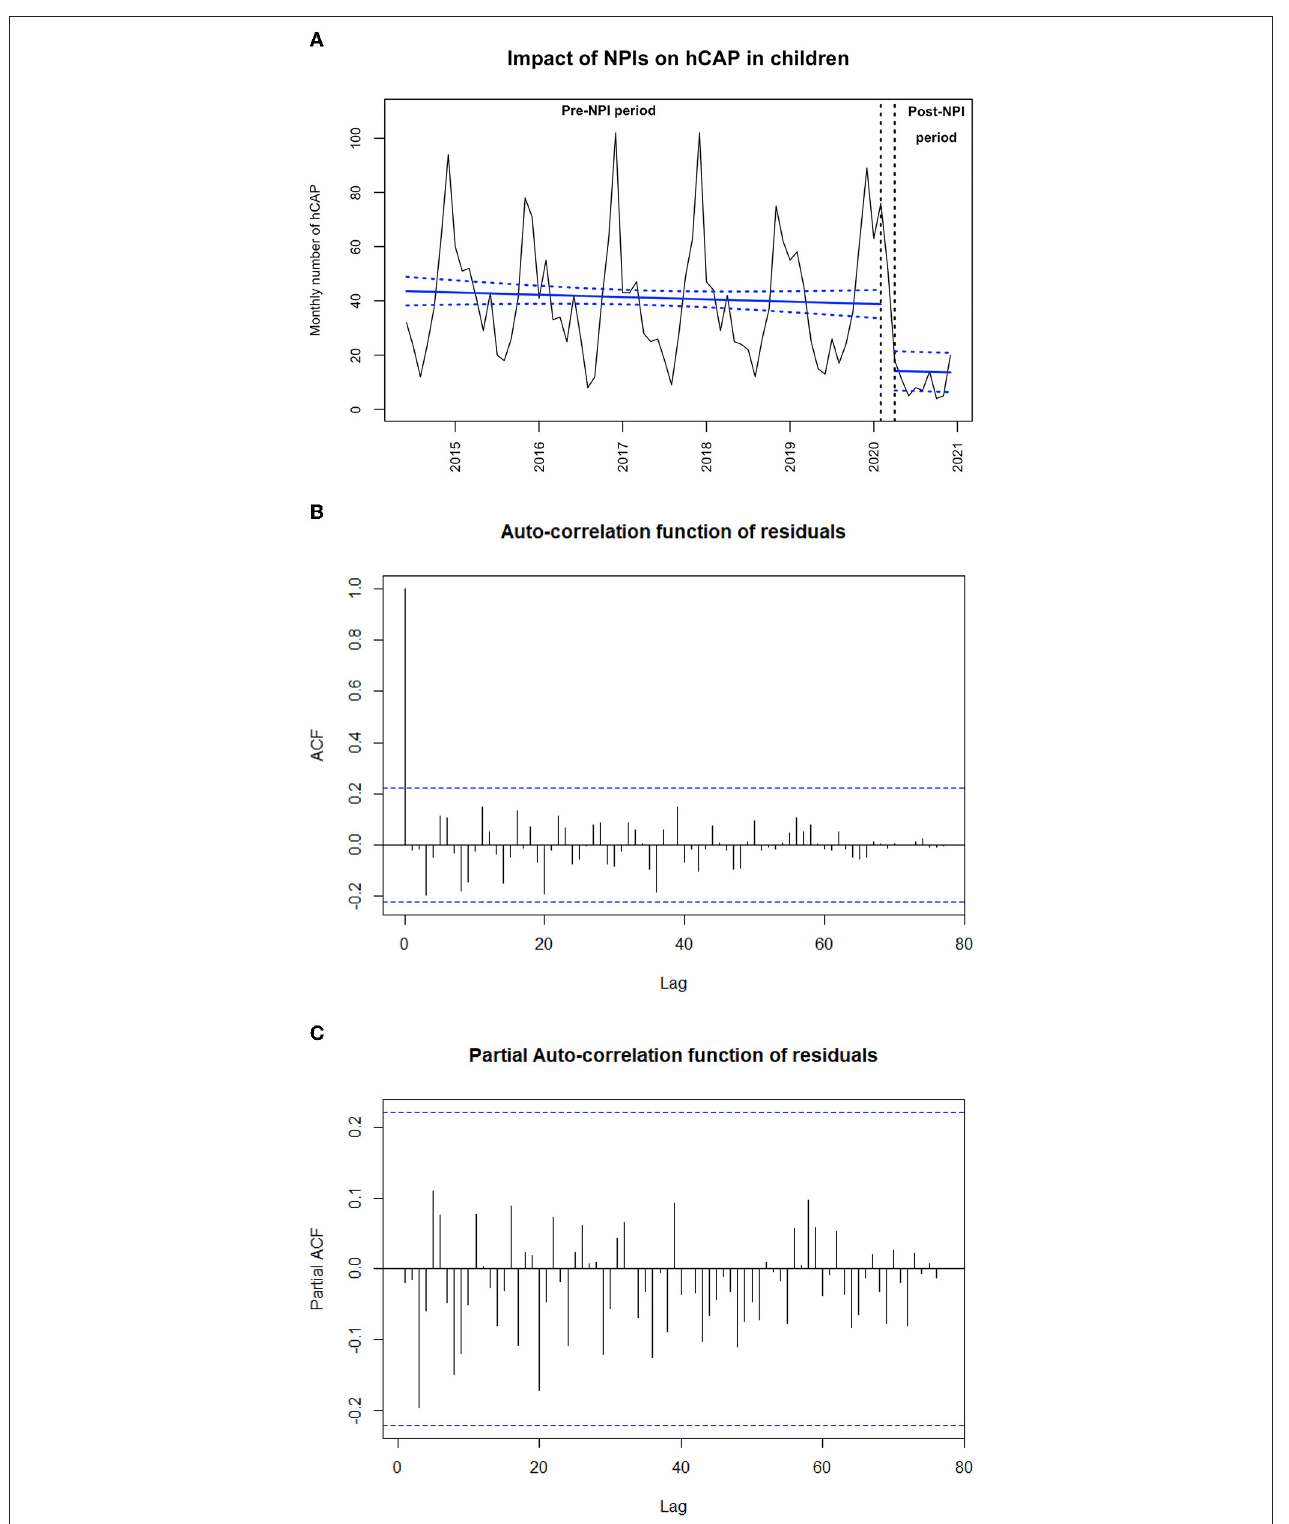
FIGURE 1 | (A) Impact of non-pharmaceutical interventions (NPIs) on monthly number of hospitalized community-acquired pneumonia (hCAP) in children from June 2014 to December 2020 ( N = 2,968). The black line shows the observed data. The bold blue slope shows the model estimates based on observed data (linear regression modeling) with confidence intervals represented as dashed lines. March 16, 2020 (start of the first lockdown), is indicated by the vertical black arrows. (B) Auto-correlation function of residuals of the main outcome model. (C) Partial auto-correlation function of residuals of the main outcome model.